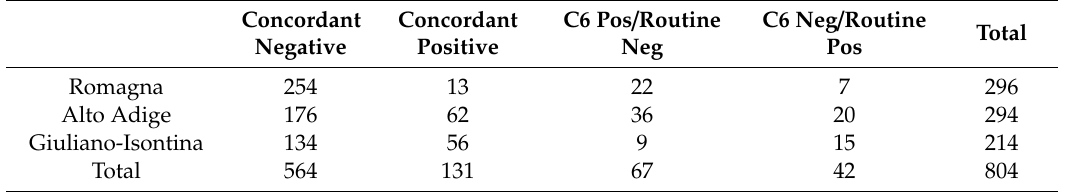
Table 2. Distribution of results per